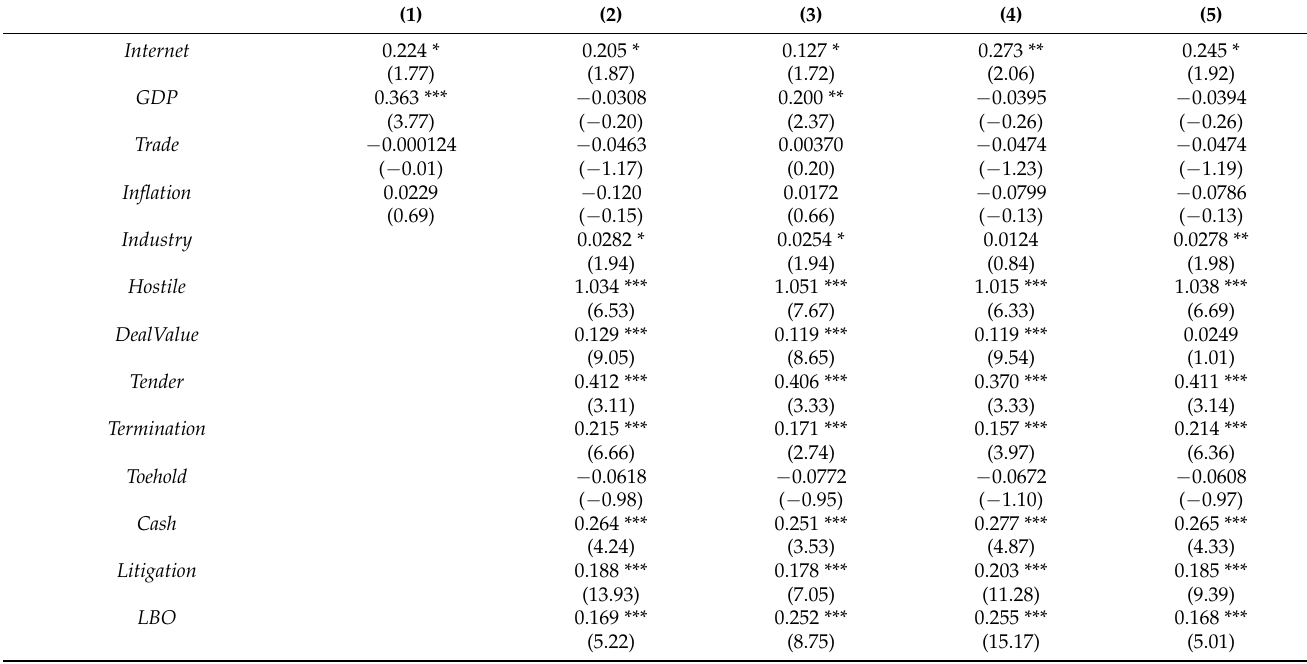
Table A8. This table presents the results of five probit regressions for the full sample of global M&A deals. The dependent variable is Compete , an indicator variable that equals 1 if a deal received a competing bid and 0 otherwise. The main independent variable is Internet , an indicator variable that equals 1 if the Internet has been introduced in the target country at the time the deal is announced. In addition to the control variables described previously, macro-economic variables for the acquiring country are included. Standard errors are double-clustered by year and